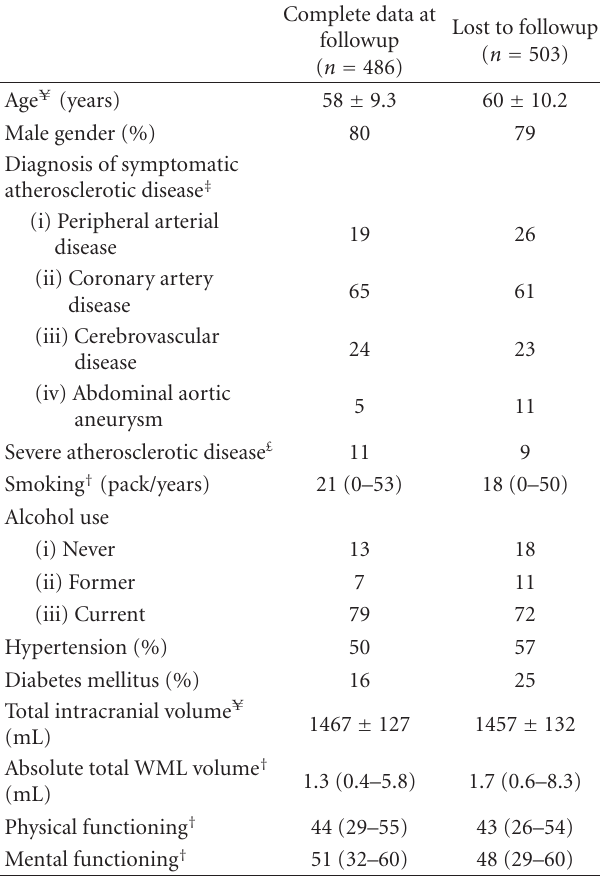
Table 1: Baseline characteristics of patients with complete data at followup and of those lost to